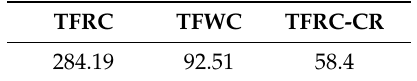
Figure 11. Instantaneous throughput of TFRC, TFWC, TFRC-CR, and OHTP. Table 2. OHTP percentage throughput improvement over transport protocols.